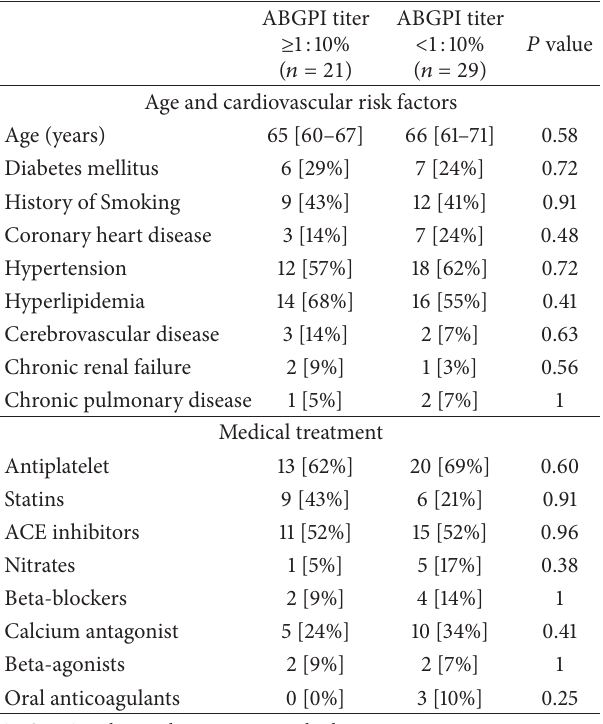
Table 1: Baseline characteristics of peripheral arterial disease patients according to circulating anti-beta2-glycoprotein I antibod- ies